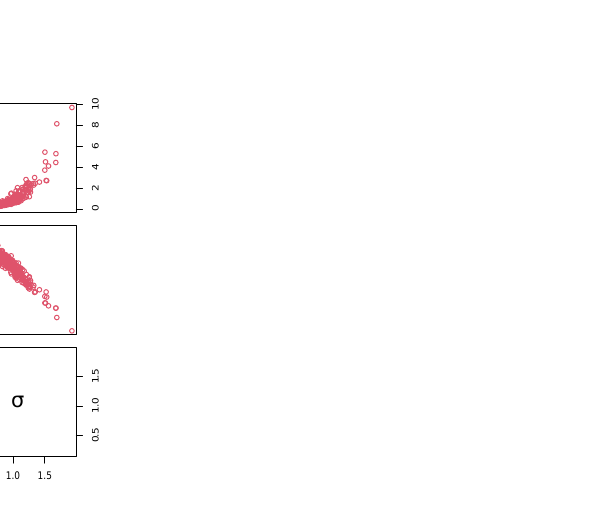
Figure 6. Matrix scatter plot on bootstrappped values of the GDUSLN parameters due to bladder cancer dataset.